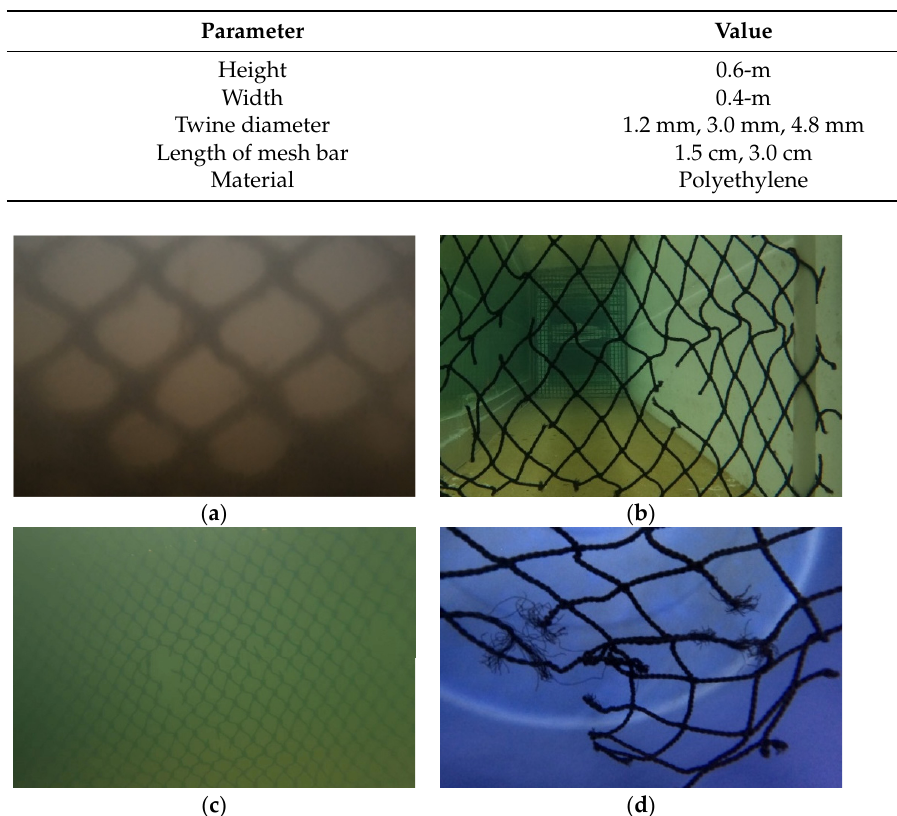
Figure 1. Sample images of damaged netting were taken under different conditions. ( a ) Real ma- rine aquaculture. ( b ) With wave influence. ( c ) With still and turbid seawater. ( d ) With still and clear seawater.